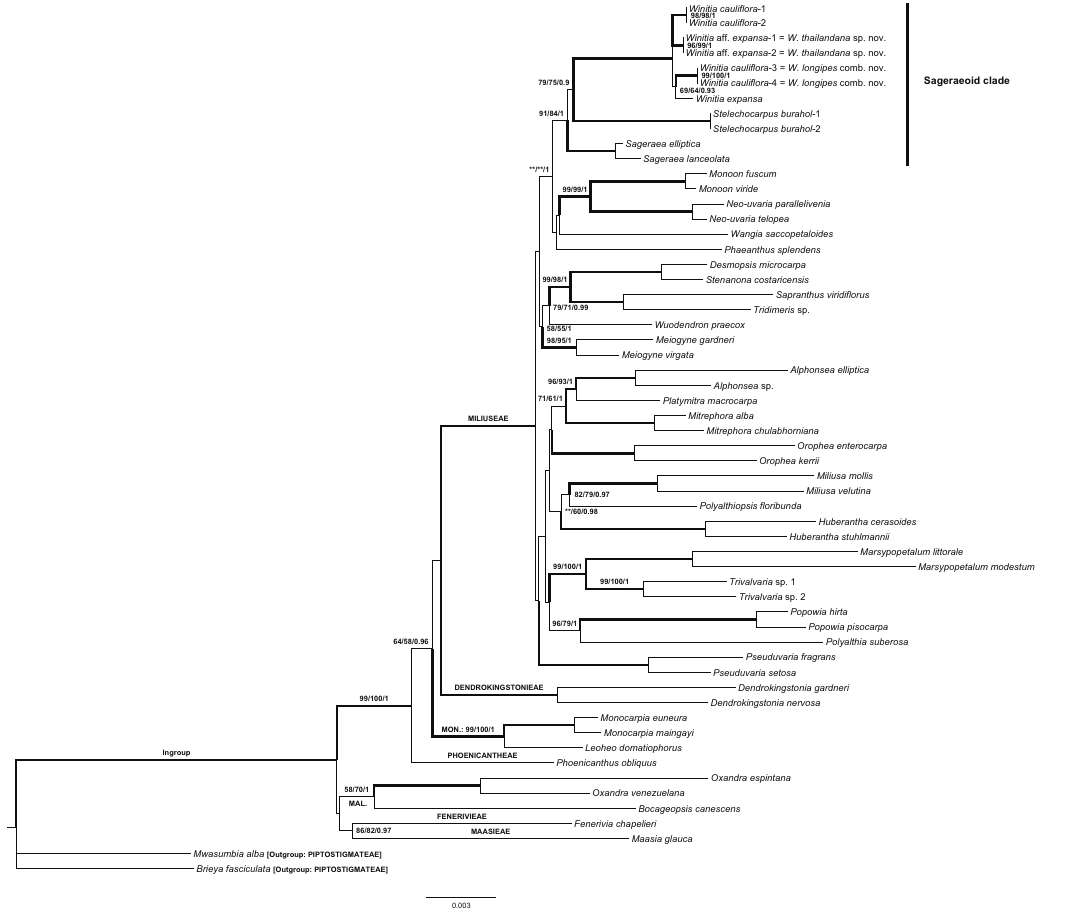
Fig. 1. Phylogram derived from maximum likelihood analysis, with support values shown: SR/BS/PP. Maximally supported clades are represented by thick branches without support values shown; strongly supported clades are represented by thick branches with support values shown; branches without support values shown signify SR < 50%, BS < 50%, and PP < 0.85. ** signifies SR/BS < 50%. Scale bar unit = substitutions per site. MAL. = Malmeeae; MON. =